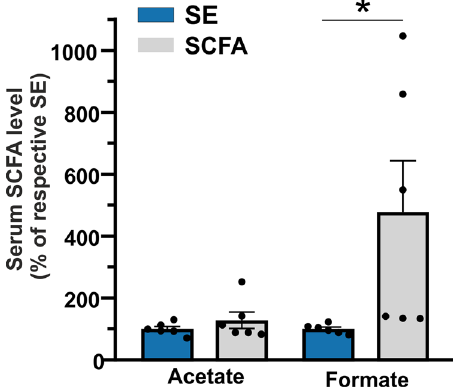
Fig. 4 Formate and acetate serum levels in SCFA-treated mice. Serum levels of acetate and formate in mice following fi ve-weeks SCFA treatment. Levels of SCFA in SE mice were taken as 100%. These were as follows: SE acetate 2.42 ± 0.39 mol/mol creatine and SE formate 0.18 ± 0.02 mol/mol creatine. Results are shown as percentage (SCFA, gray, acetate n = 6, p = 0.170; formate n = 6, * p = 0.023 vs SE by Student-t test) of respective SE mice (blue). Values are given as mean ± SEM of two independent